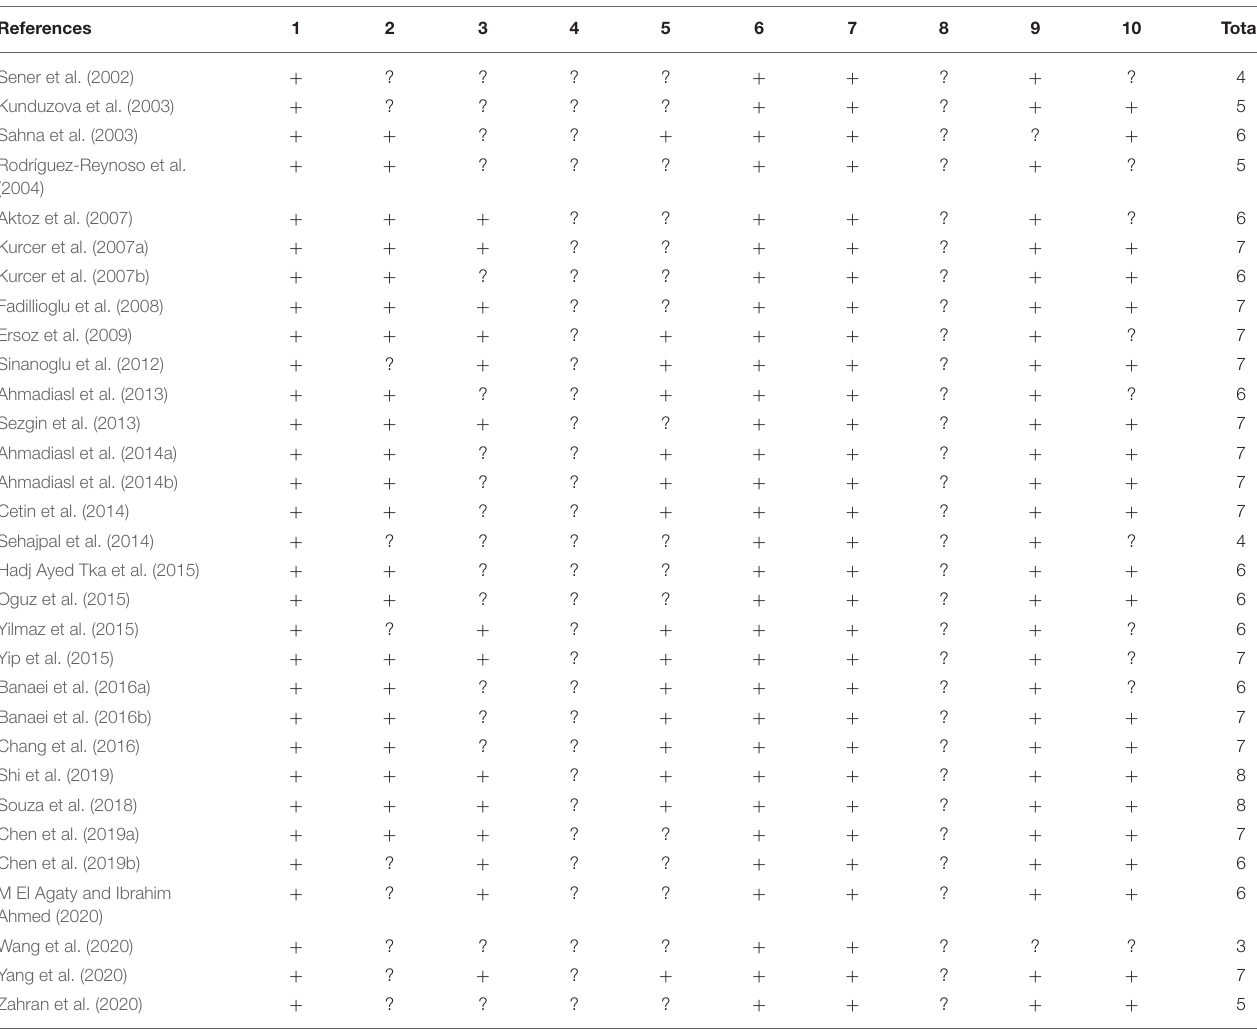
TABLE 2 | The research quality of included